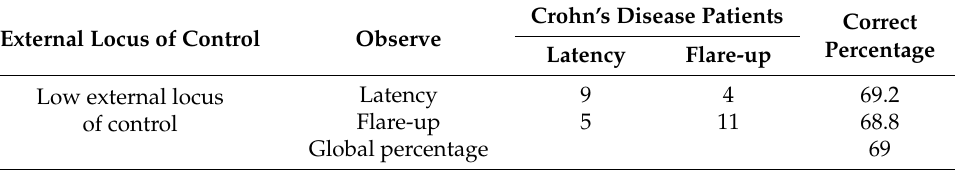
Table 5. Prediction of the probability of a flare-up in subjects with a low external locus of control. External Locus of Control